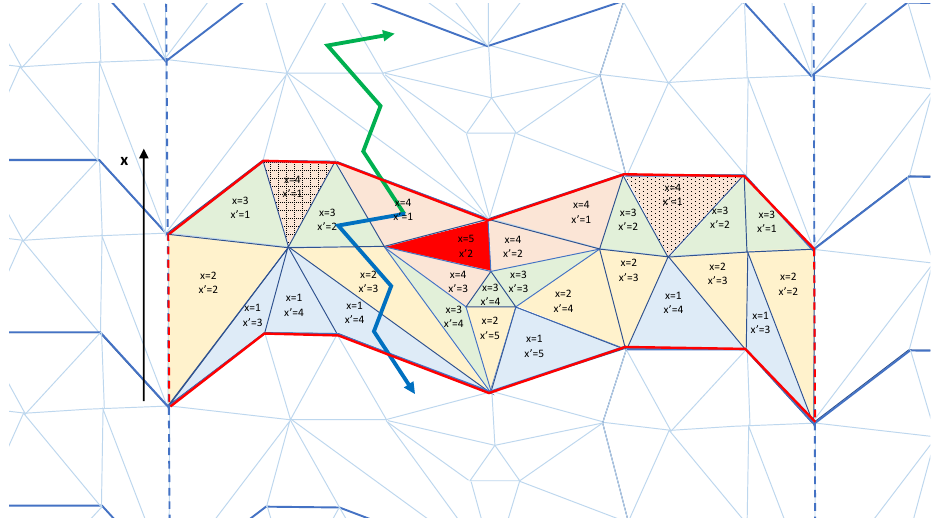
Figure 7. A (two-dimensional) visualization of a triangulation (colored triangles) with toroidal topology. The (smallest) boundary orthogonal to the x direction is plotted as a red solid line, and the boundary orthogonal to the other direction as a red dashed line (the red solid lines, as well as the red dashed lines, are identified). Different colors mark different x coordinates. All triangles of the same color and texture form single slices. For x = 1,2,3,5, one has only a single slice for each x coordinate, but for x = 4, one can distinguish three separate slices. All triangles but the dark red one belong to the trunk, and the dark red triangle belongs to a branch. For each triangle, one can find (one or more) minimal loops with a nontrivial winding number: all triangles whose centers are marked by a solid zigzag arrow belong to the same 1,0 loop (green arrow) and also to the same { } 1,0 loop (blue arrow); the length of these loops is {− }